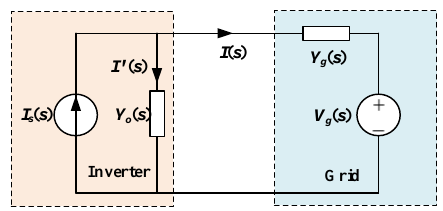
Figure 7. Model of a single-inverter grid-connected system.